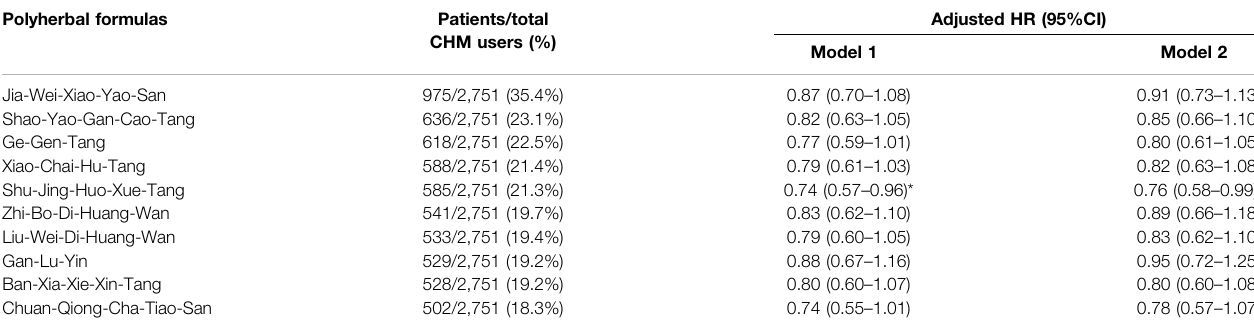
Model 1: adjusted for age, gender, insured amount, and urbanization level. Model 2: adjusted for age, gender, insured amount, urbanization level, comorbidities, and baseline drugs. HR, hazard ratio; CHM, Chinese herbal medicine; CI, con fi dence interval. * p -value < 0.05.